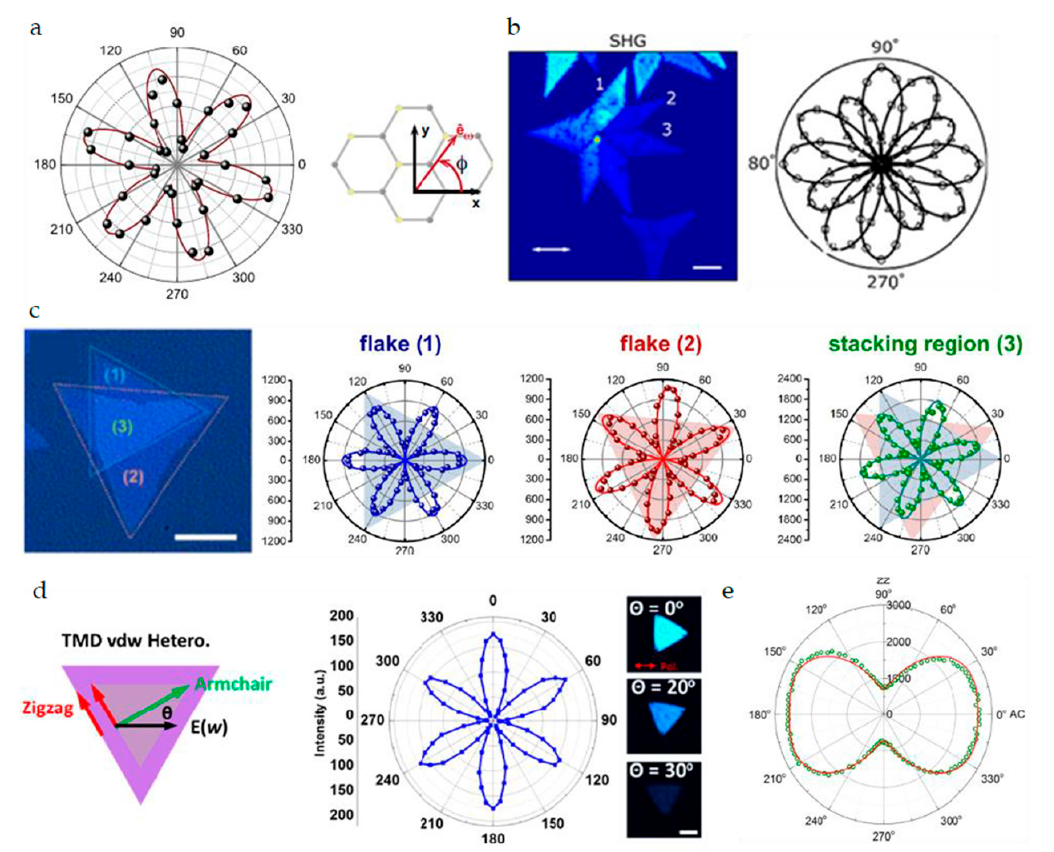
Figure 6. ( a ) Polar plot of the SHG intensity from monolayer MoS 2 as a function of the sample angle. Reproduced from [57], with permission from American Physical Society, 2013. ( b ) SHG intensity depends on orientation of the flakes and laser polarization. Reproduced from [58], with permission from American Chemical Society, 2018. ( c ) The underlying crystal symmetry and crystal orientation of individual monolayer MoS 2 flakes and the stacking regions can be further examined by the polarization-resolved SHG. Reproduced from [62], with permission from American Chemical Society, 2014. ( d ) Identification of symmetry and edge structures of lateral transition metal dichalcogenide heterostructures with SHG analysis. Reproduced from [63], with permission from American Chemical Society, 2015. ( e ) The BP flake polarization dependence of THG. Reproduced from [51], with permission from AIP Publishing, 2016.